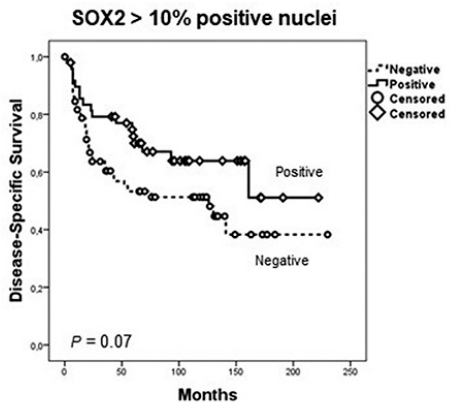
Figure 3. Kaplan–Meier disease-specific survival curves in the cohort of 125 patients with oral squamous cell carcinoma dichotomized according to SOX2 staining (positive versus negative). P -values were estimated using the log-rank test.